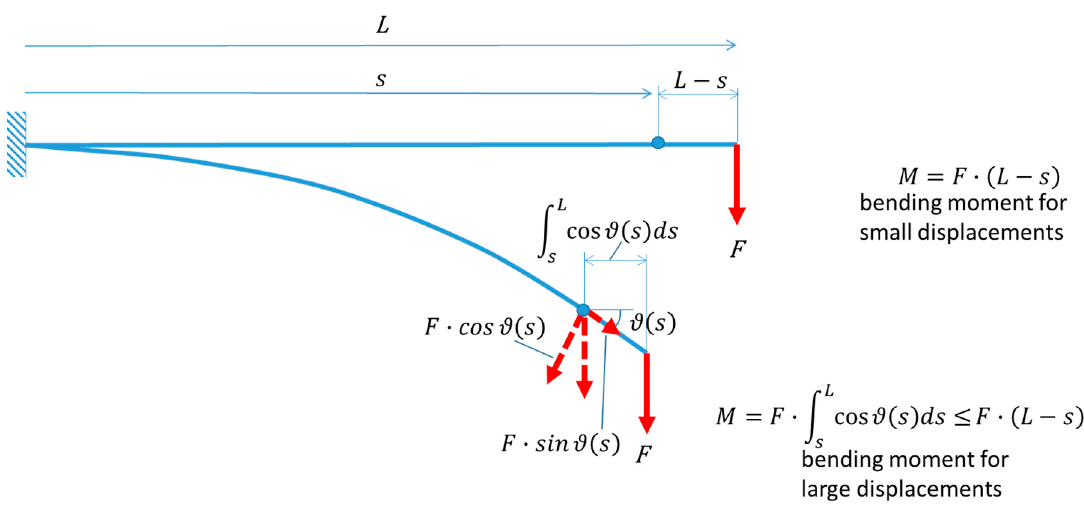
Figure 3. E ff ect of the large displacement on the load distribution. Figure 3. Effect of the large displacement on the load distribution.